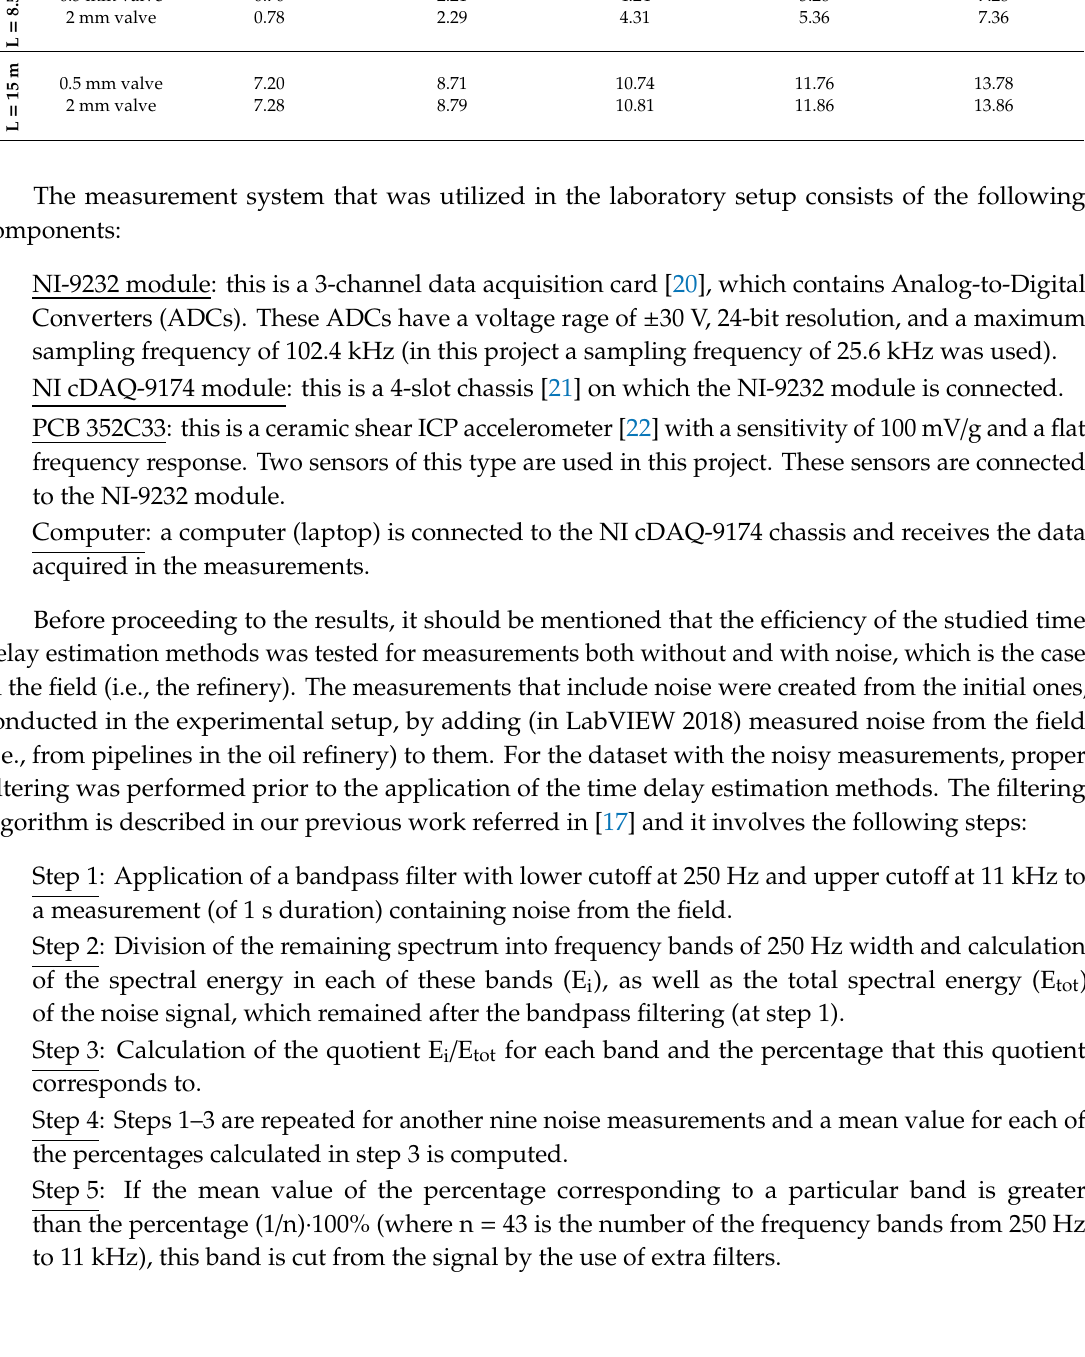
Table 1. Positions of the utilized valves on the pipeline. Positions of the 1st Group Valves